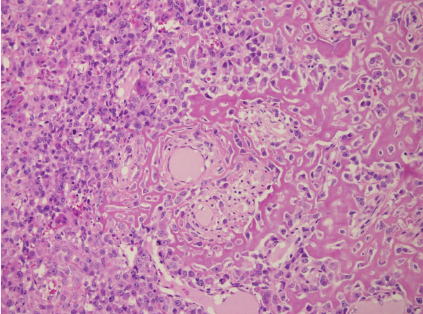
Figure 2: Tumor cells associated with band of osteoid with osteoblastic cells (hematoxylin-eosin 20x).